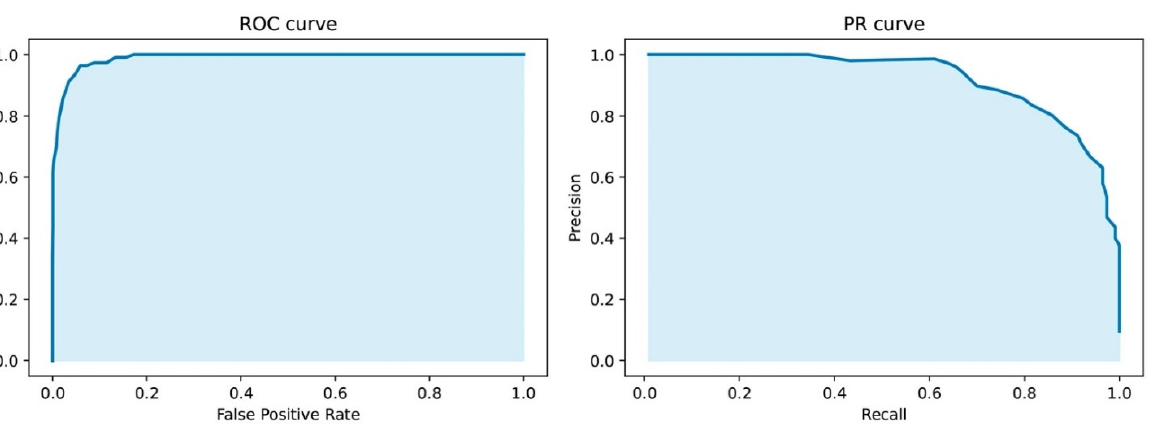
Figure 1. Workflow for studying differences in PUFA regulation between normal and breast cancer samples. Starting from the processed expression matrixes of the corresponding datasets taken from the GEO database, the training and test sets are constructed. To avoid the effect by platform differences, gene expression data within each sample are then converted to the ranks. PUFA genes are selected for the subsequent analysis (See details in the Section 2).